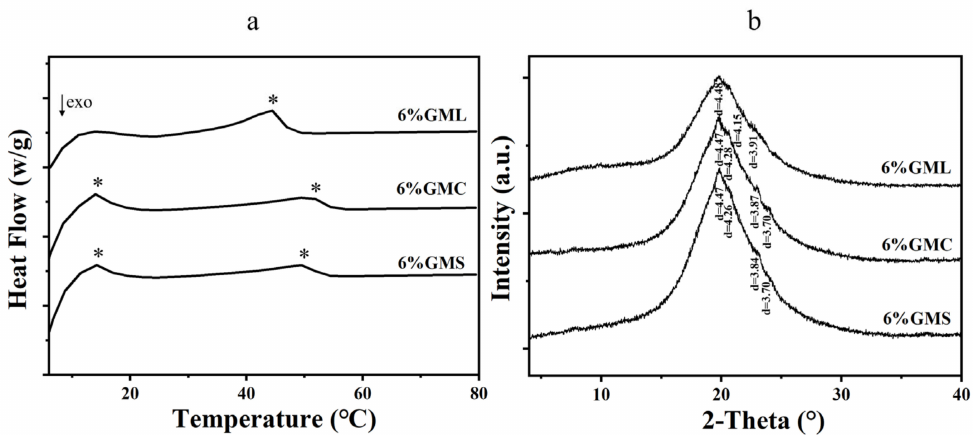
Figure 4. DSC Patterns ( a ) and X-ray Diffraction Patterns ( b ) of oleogels with 6% concentration. The * represents the endothermic peak of the oleogel